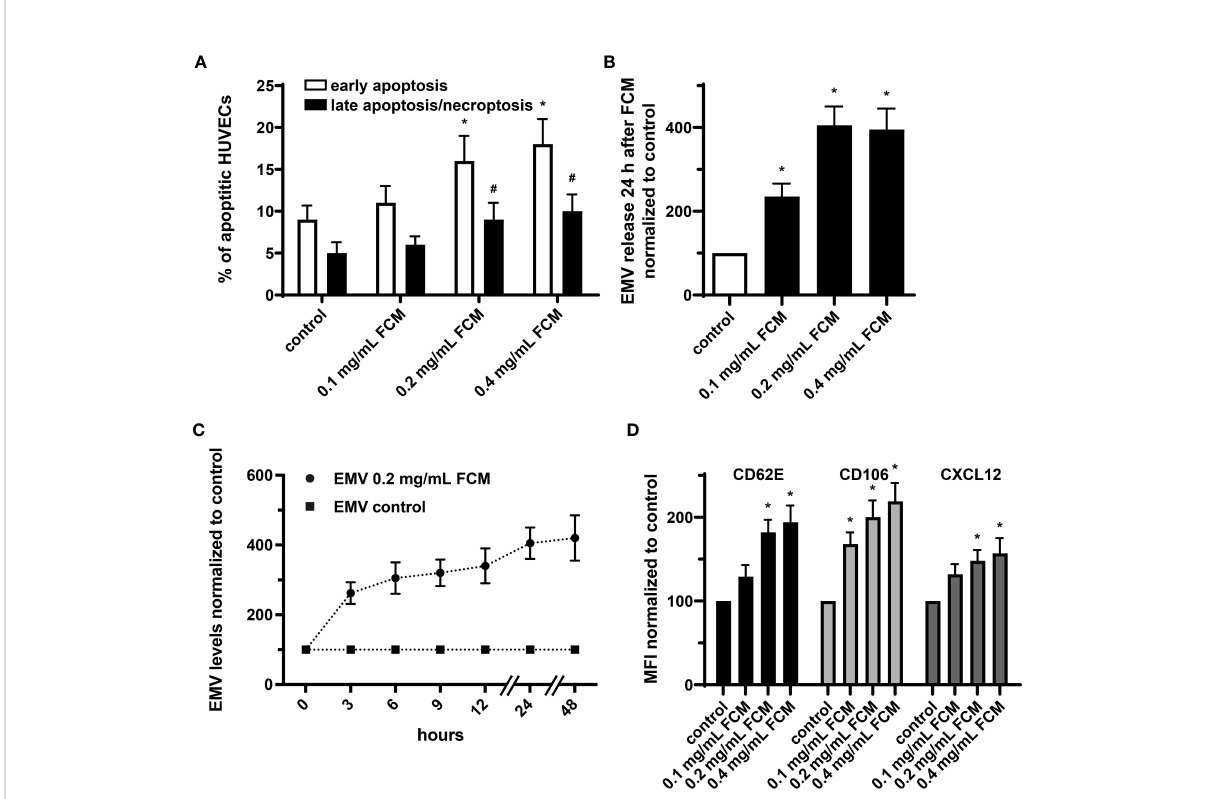
FIGURE 5 FCM exposure induces apoptosis and in fl ammatory activation of HUVECs and promotes release of EMVs. (A) Annexin V-FITC/PI staining with subsequent fl ow cytometry analysis to determine the rate of apoptotic HUVECs treated as indicated for 24 hours. *p < 0.05 vs. untreated HUVECs (control) for early apoptosis, # p < 0.05 vs. control for late apoptosis/necroptosis; n = 5. (B) Analysis of EMV release by HUVECs treated as indicated for 24 hours. Levels of HUVEC-derived EMVs were normalized to untreated HUVECs (control). *p < 0.05 vs. untreated HUVECs (control); n = 6. (C) Time course analysis of EMV release by HUVECs kept untreated or treated with 0.2 mg/mL FCM for indicated time points. Levels of EMVs derived from FCM-treated HUVECs were normalized to levels of EMVs derived from untreated HUVECs for each time point (control); n=5. (D) Flow cytometry-based assessment of CD62E, CD106 and CXCL12 on the surface of HUVECs treated as indicated. Data are expressed as mean fl uorescence intensity (MFI) in % normalized to untreated HUVECs (control). *p < 0.05 vs. untreated HUVECs (control) for the respective marker; n =